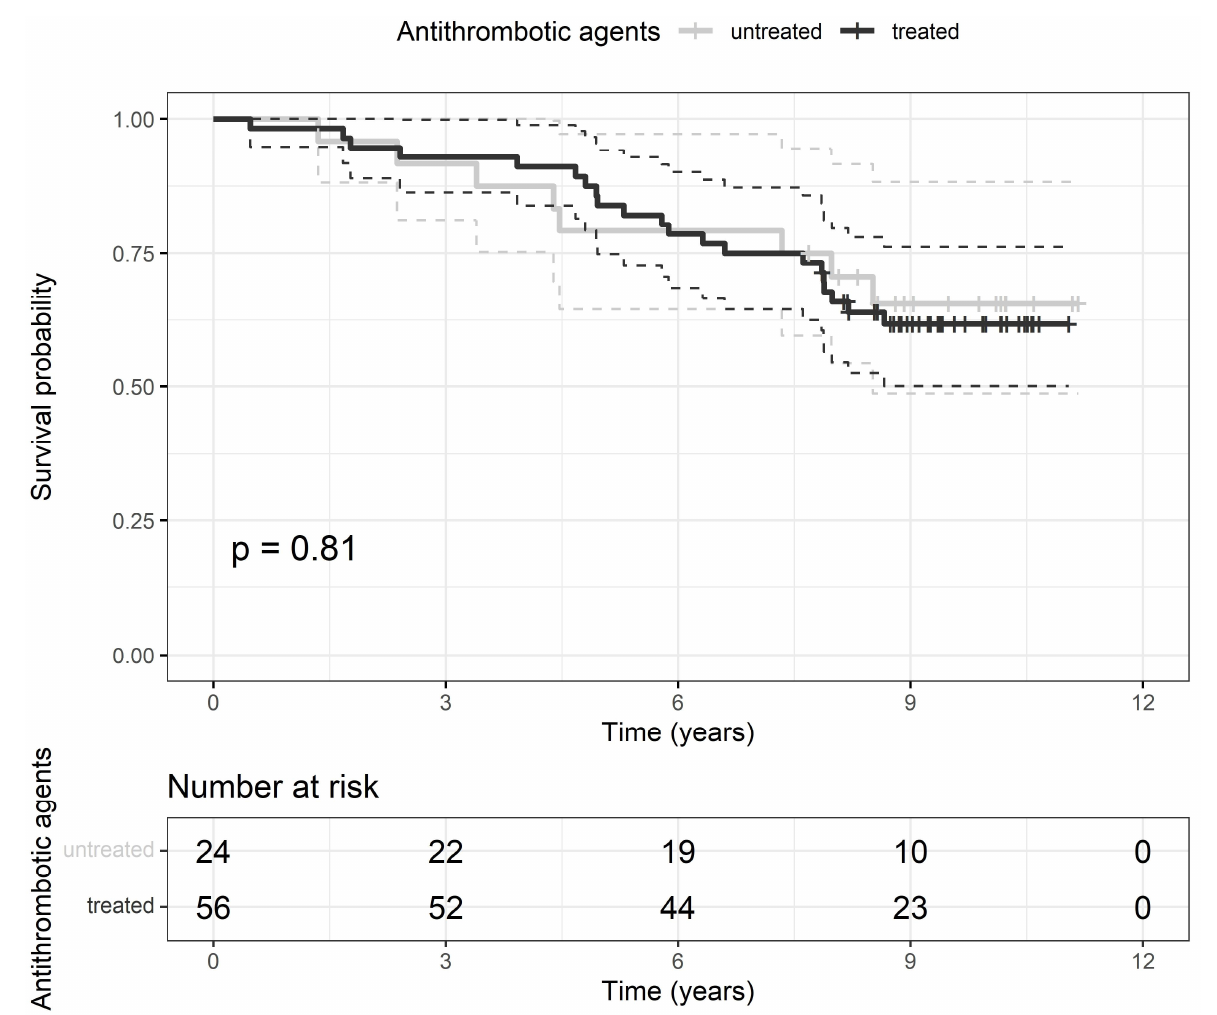
Figure 3. Kaplan-Meier curves of the composite endpoint rate after receiving (black line) or not (grey line) the antithrombotic treatment with the respective 95% confidence interval (dashed black or grey lines). Vertical marks represent censored patients. Below the graph is reported a table with the number of patients at risk treated and untreated with antithrombotic agents at each time-point. p , probability for the difference between groups by log-rank test.